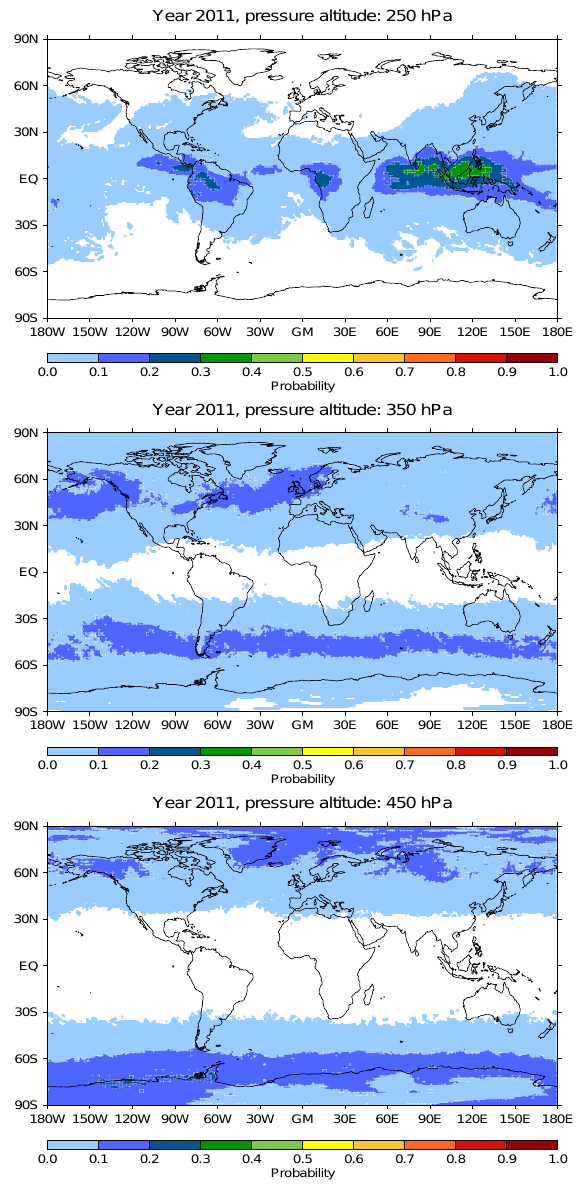
Fig. 6. As Fig. 4, but only regions where an aerodynamic contrail Fig. 6. As figure 4, but only regions where an aerodynamic contrail would be persistent (i.e. where the ambient air is ice supersaturated) are would be persistent (i.e. where the ambient air is ice supersaturated) shown. are